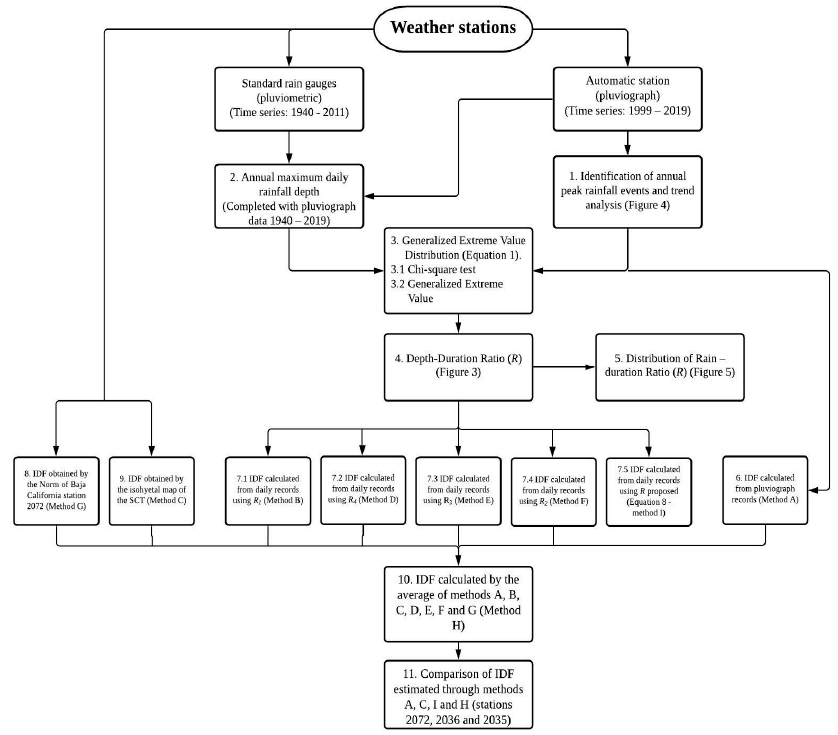
Figure 2. General diagram of the methodology.